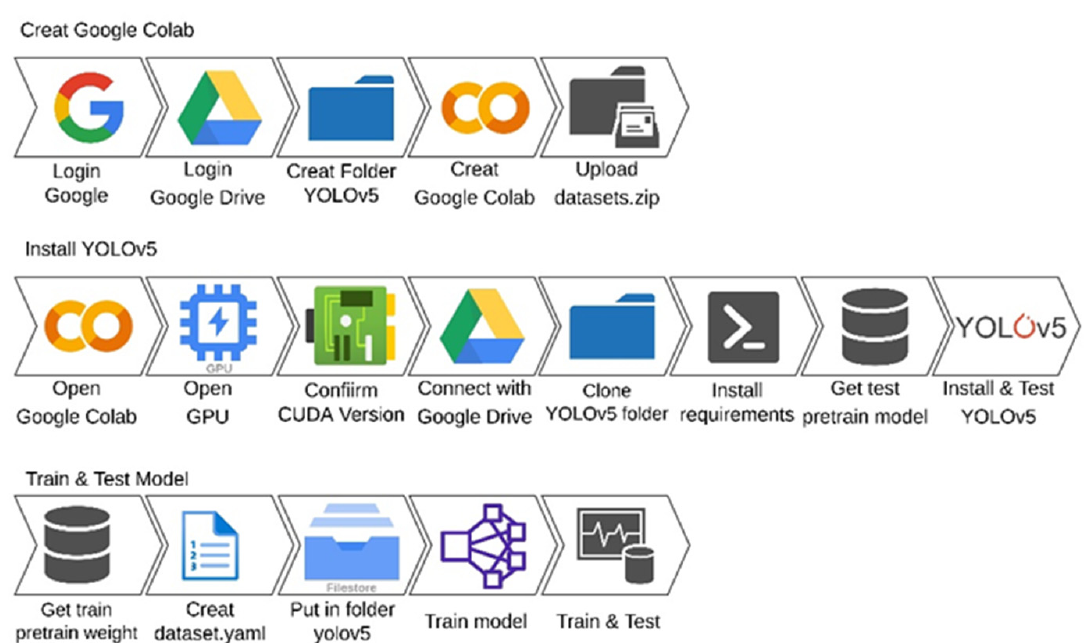
Figure 4. Implementation of YOLOv5 for model training and testing with Google Colab.